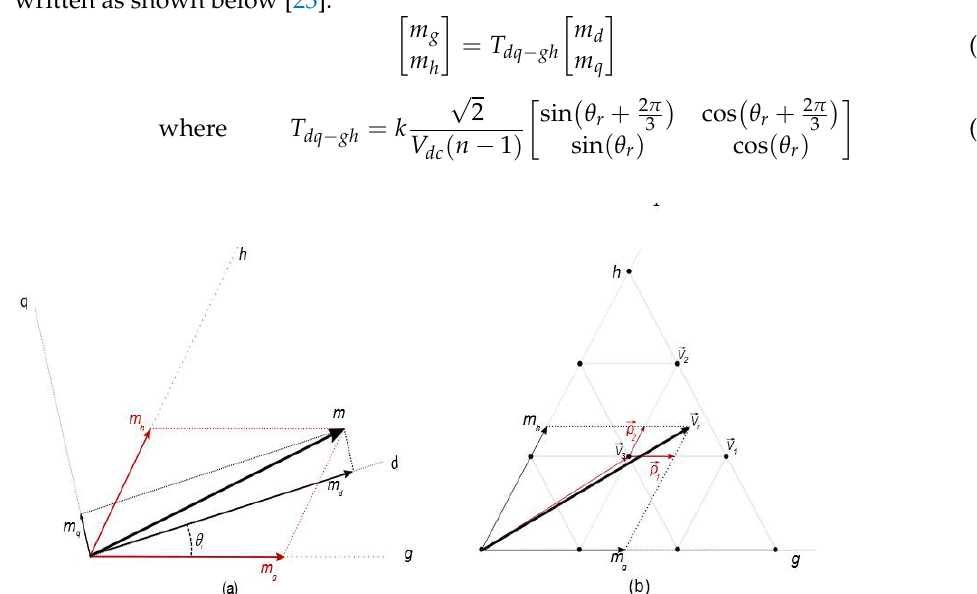
Figure 3. ( a ) dq–gh transformation; ( b ) projection of reference vector.